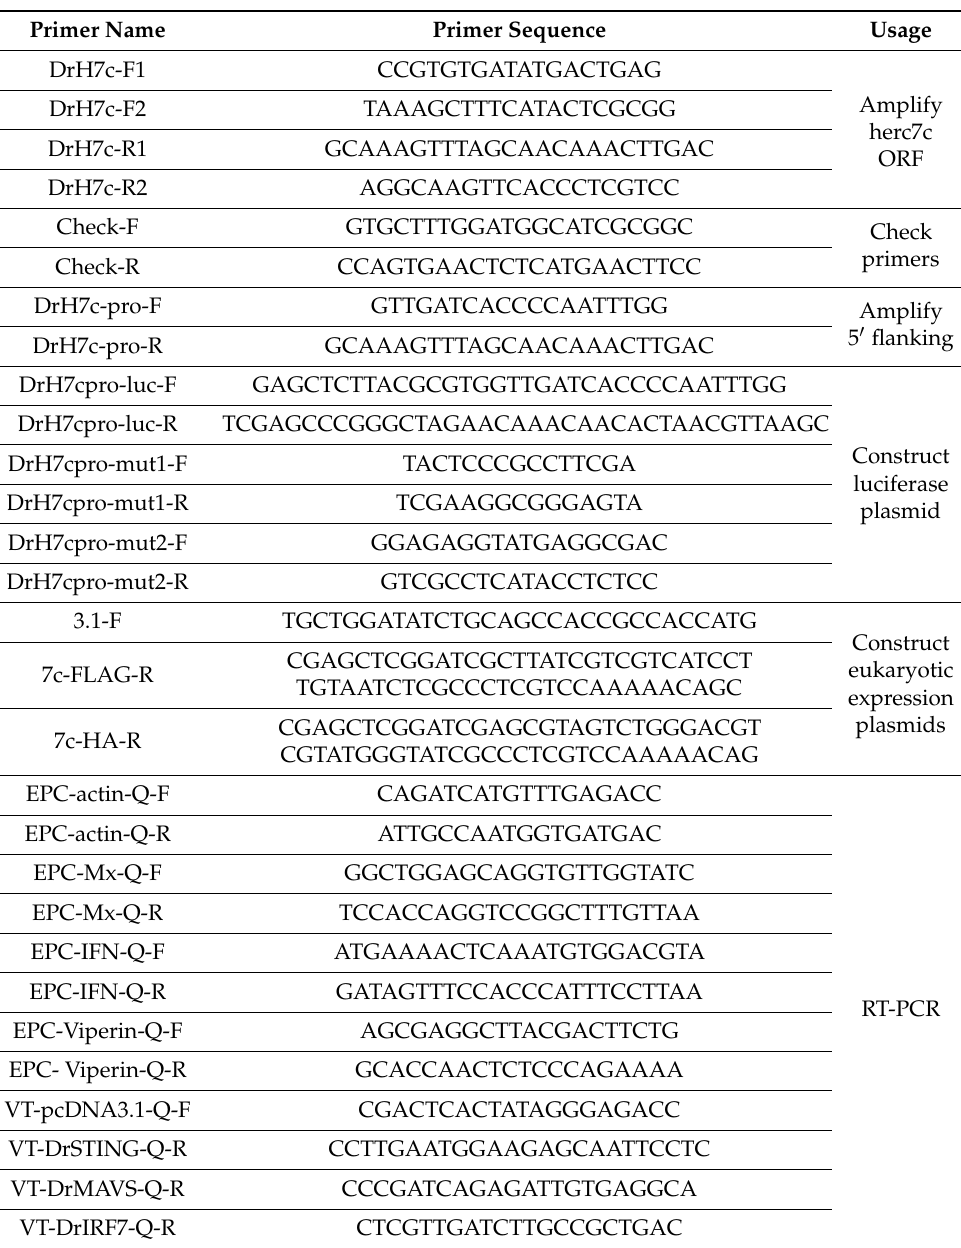
Table 1. The primers used in this